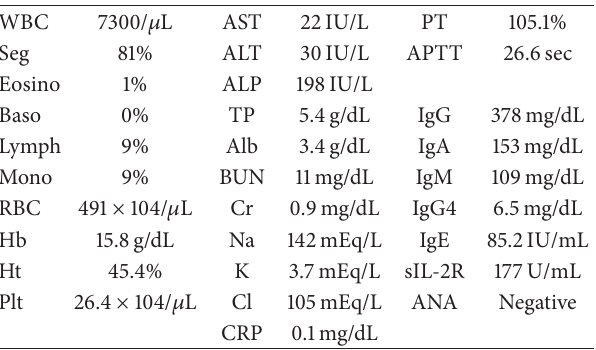
Table 1: Laboratory data on